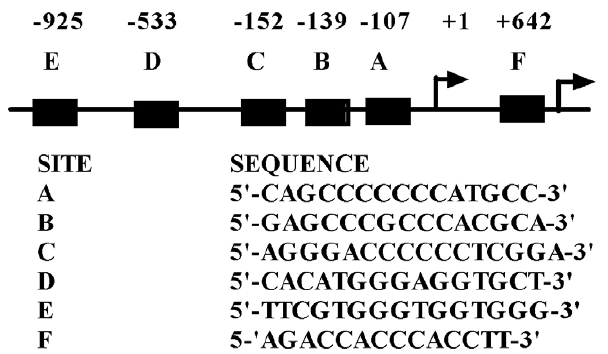
Figure 1. Five Novel Putative GLI Binding Sites Lie Within the First Human TGF- b 1 Promoter. There are two reported promoters in the human TGF- b 1 gene. In silico analysis of the human TGF- b 1 proximal promoter regions using the Genomatix software program revealed five previously unidentified putative GLI-binding sites (A through E) in a highly conserved region of the human genome. Site F in the second promoter has previously been identified and studied [28]. Sites A and B (which overlaps with C), all lie within the luciferase reporter construct phTG5 used in the promoter mutagenesis studies. Site E is present in the phTG1 construct. Approximate base pair positions of potential GLI binding sites are shown relative to the two reported transcription start sites for the human TGF- b 1